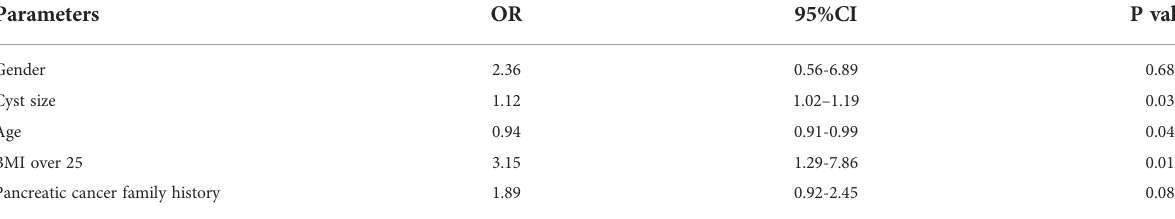
TABLE 3 Multivariate predictors for clinical signi fi cance EUS-FNA in low-risk PCLs patients.